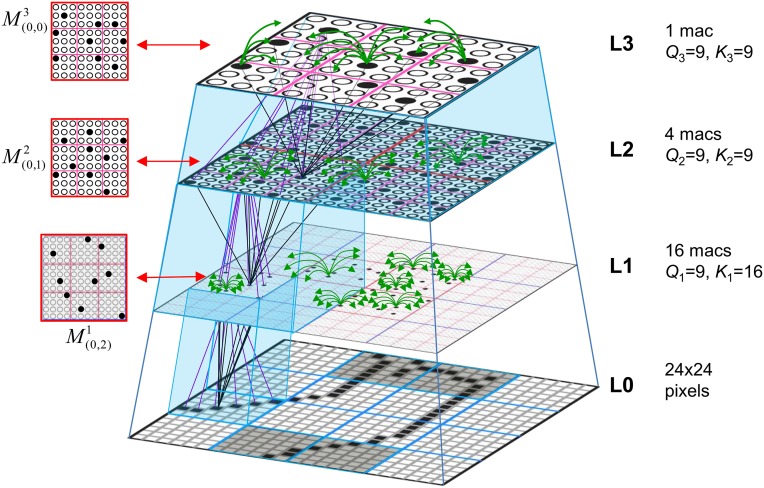
The 4-level model used in Study 2. Blue semi-transparent prisms show the U-RFs of the macs at the prism tops, i.e., the L3 mac M3(0,0)'s U-RF contains all four L2 macs, each L2 mac's U-RF contains the four underlying L1 macs, and each L1 mac's U-RF is the underlying 6 × 6-pixel L0 aperture. At left, we show plan views of individual macs showing their active codes at the particular spatiotemporal moment depicted (T = 15 of Snippet 1). The four gray L0 apertures have too few/many active pixels for their associated L1 macs to activate. Subsets of the U (black), H (green), and D (magenta) wts are shown.